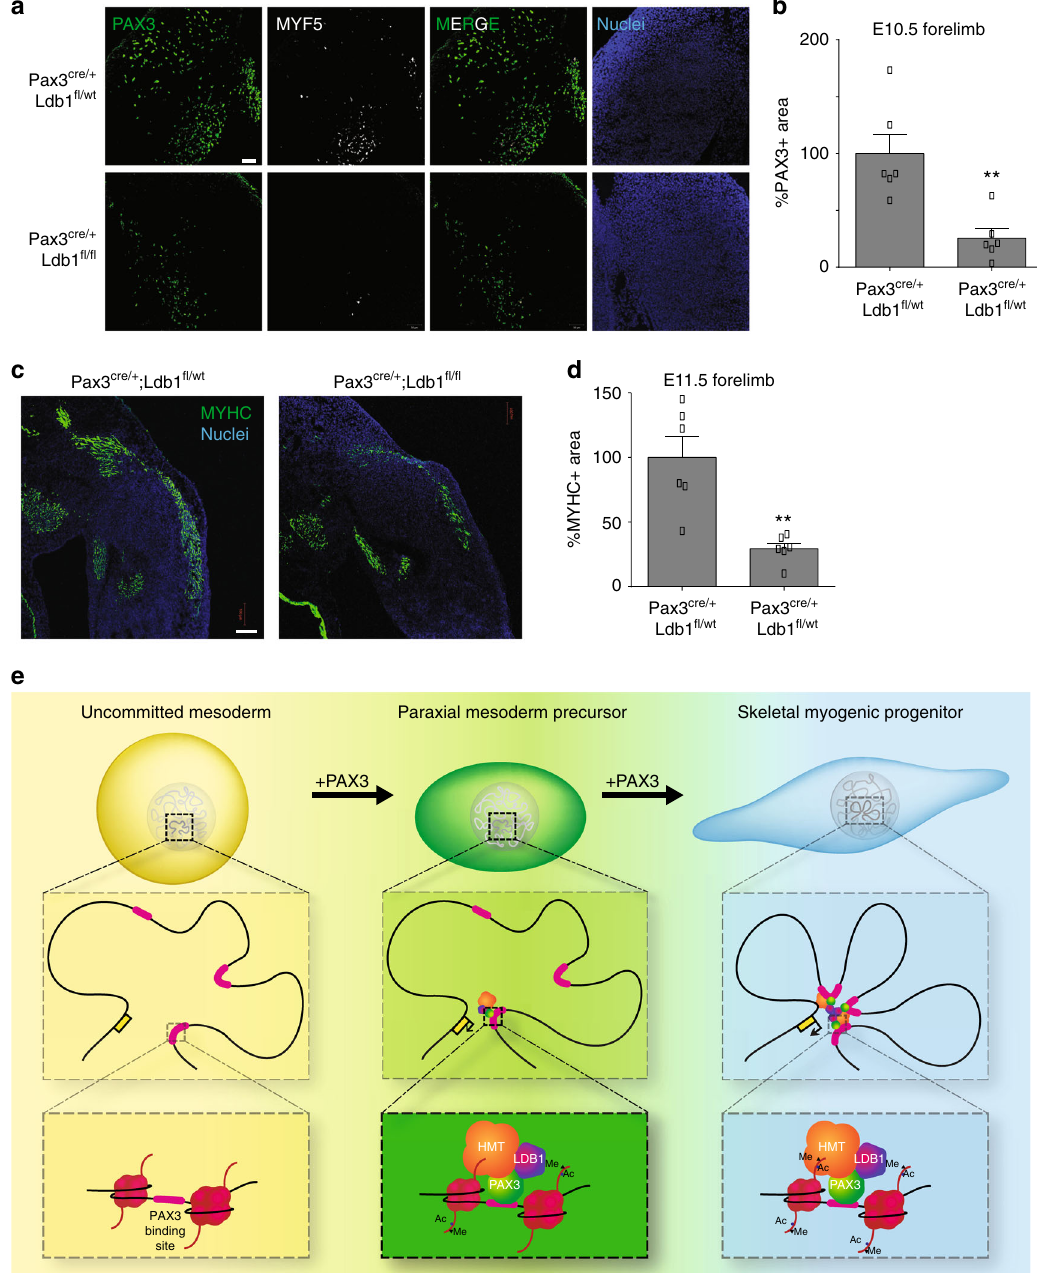
Fig. 7 Ldb1 is required for hypaxial myogenesis. a Myogenic progenitor migration is impaired upon Ldb1 deletion in the Pax3 lineage. Representative immunostaining of cryosections from E10.5 Ldb1-deleted embryos reveals reduced numbers of PAX3 + cells (green) in the forelimb bud. MYF5 (white); nuclei (blue). Bar: 100 µ m. Images are representative of at least three independent embryos (from distinct matings). b Quanti fi cation of PAX3 + signal from panel a . Graph represents mean + s.e.m. from three independent embryos ( n = 3) (D). Student ’ s t -test * p < 0.05. c Immunostaining of E11.5 cryosections using MYHC antibody con fi rms the impaired migration observed in E10.5 embryos. MYHC (green); nuclei (blue). Bar: 100 µ m. d Quanti fi cation of MYHC + signal from panel c . Graph represents mean + s.e.m. from independent embryos ( n = 3). Student ’ s t -test *** p < 0.001. e Schematized model of Pax3-induced myogenic commitment. Pax3 regulates chromatin remodeling and looping by recruiting the histone methyltransferase (HMT) complex and Ldb1. Source data are provided as a Source Data fi